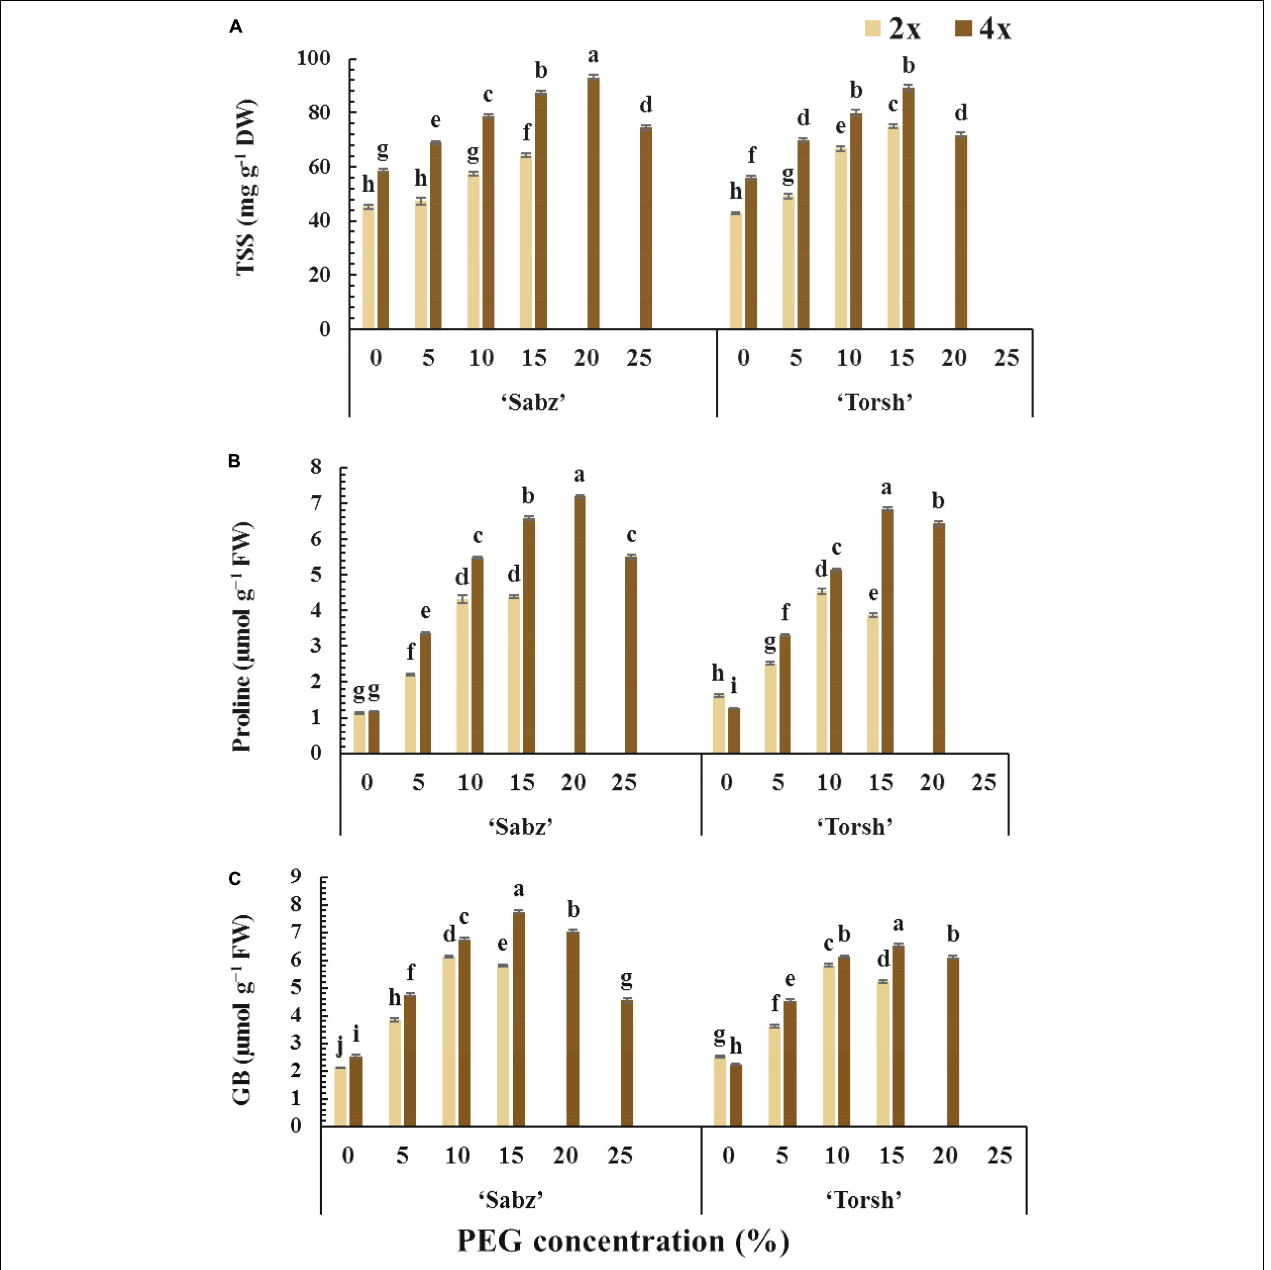
FIGURE 5 | The comparison of non-enzymatic defense system responses of tetraploid and their diploid control explants of ‘Sabz’ and ‘Torsh’ fig cultivars, 14 days after subjecting to different water stress treatments. (A) Total soluble sugars, (B) proline, and (C) glycine betaine. Means represent the ploidy level and PEG treatment effects tested by two-way ANOVA. Each value represents the means ± SE. Different letters indicate significant differences at P < 0.05 using the LSD